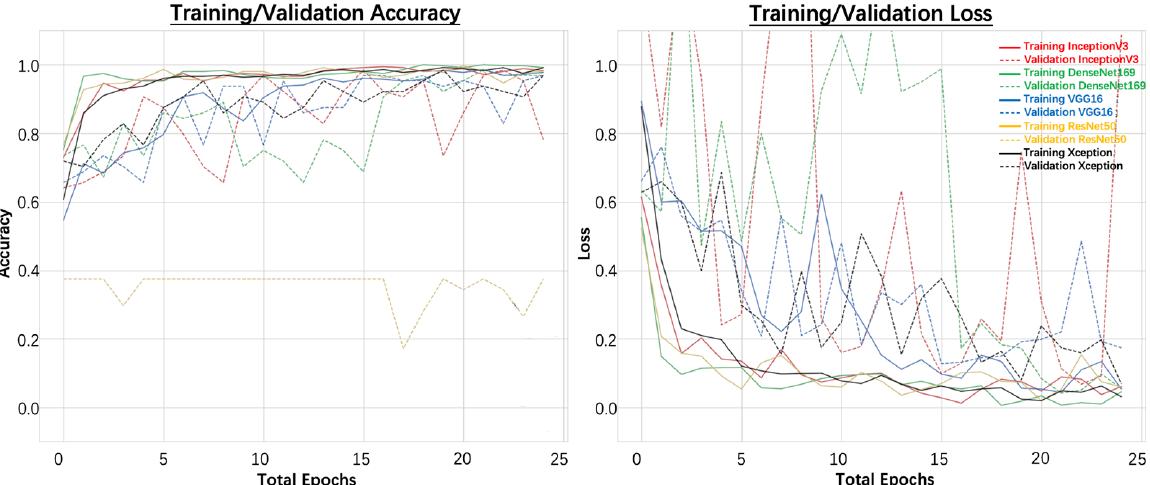
Figure 7. Training and validation accuracy and loss plots for training deep learning models to iden ‐ tify diseased regions using SLIC segments with a compactness (m) value of 5.